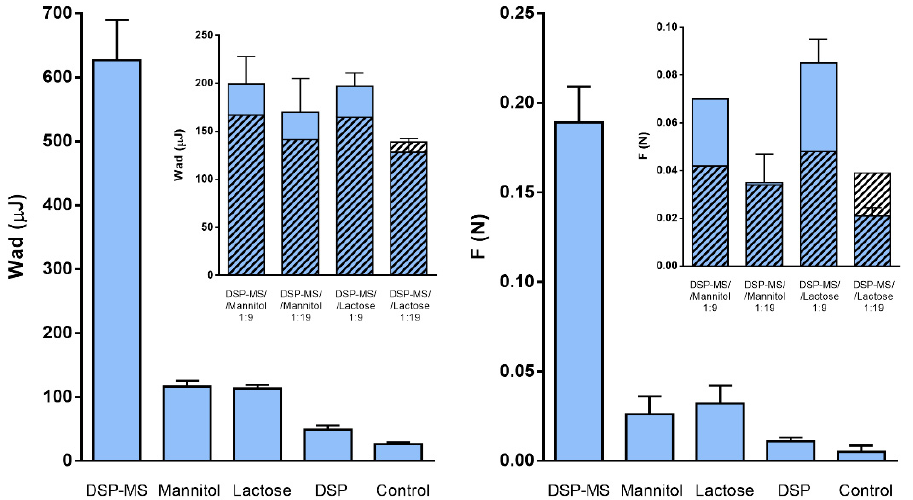
Figure 8. Work of adhesion ( W ad ; left ) and maximum detachment force ( F ; right ) of DSP-MS microspheres, inert carriers (mannitol and lactose) and pure drug powder compared to control (filter paper). Graph insert: Work of adhesion ( W ad ; left ) and maximum detachment force ( F ; right ) for DSP-MS/inert carrier blends at ratios 1:9 and 1:19 ( w/w ). For all graphs, bars coloured in blue represent measured values W ad ( left ) and F ( right ) for 5 mg of each tested powder. Shaded bars represent theoretical values for W ad ( left ) and F ( right ) calculated based on weight ratios and individual parameter values of powder blend constituents presented in the main graph. Data are expressed as the mean ± SD ( n = 3).